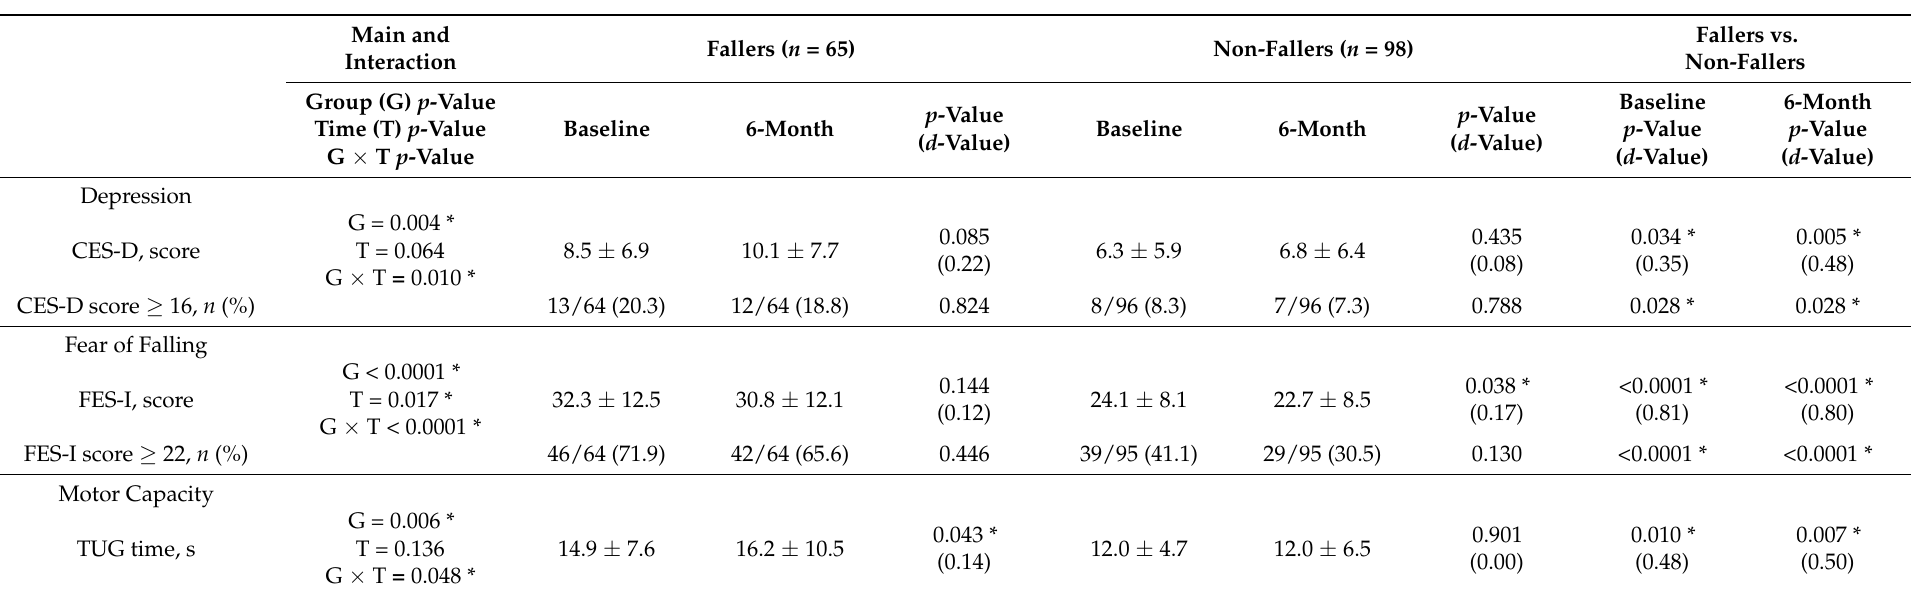
Table 4. Main and interaction effects and comparison of depression, fear of falling, and motor capacity variables as a function of the assessment time (baseline and 6-month) and group (fallers and